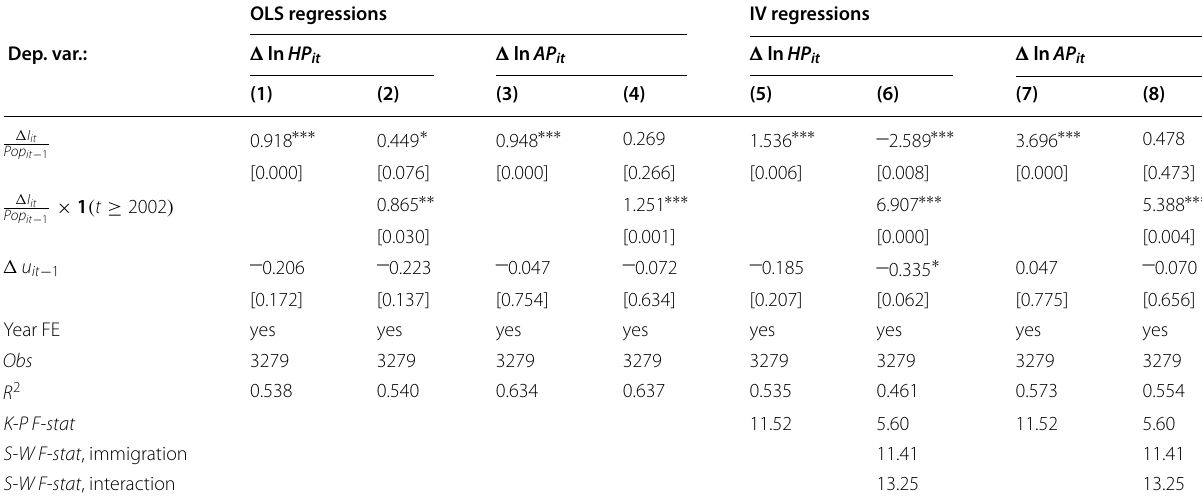
Table 4 House prices and immigration—MS-regions from 1985–2016: OLS and IV regressions. Source: Own calculations based on data from Wüest Partner and Federal Statistical